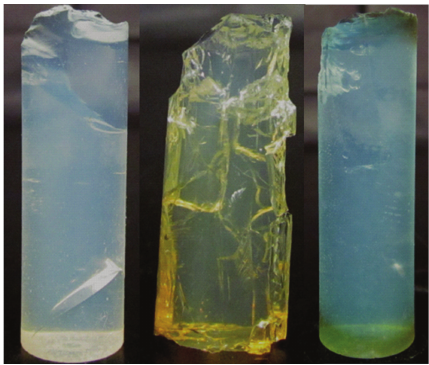
Figure 2: MG 2 -Fe and MG 2 -Cu at 500 ◦ C.